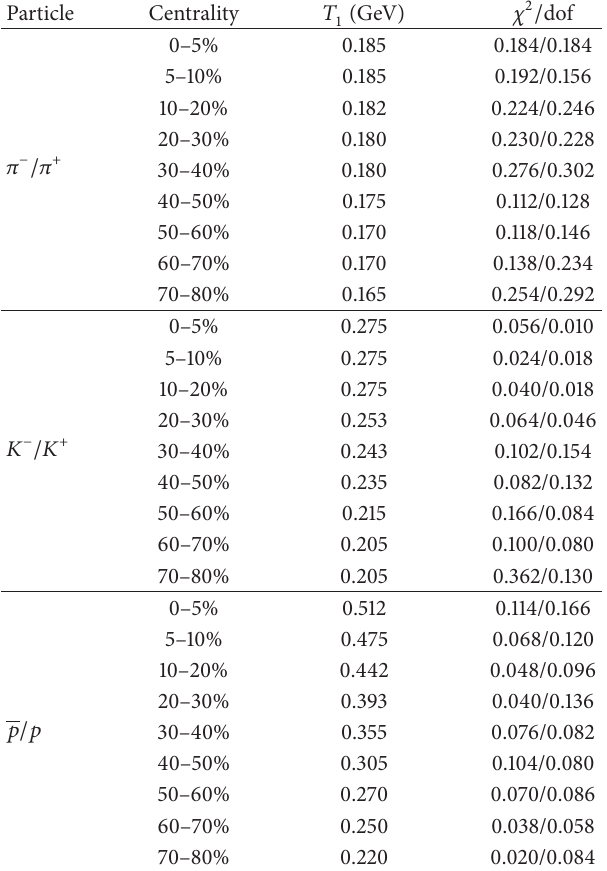
Table 5: Parameter values corresponding to the curves in Figure 5(a)/Figure 5(b). The collisions are Au + Au at 62.4 GeV.